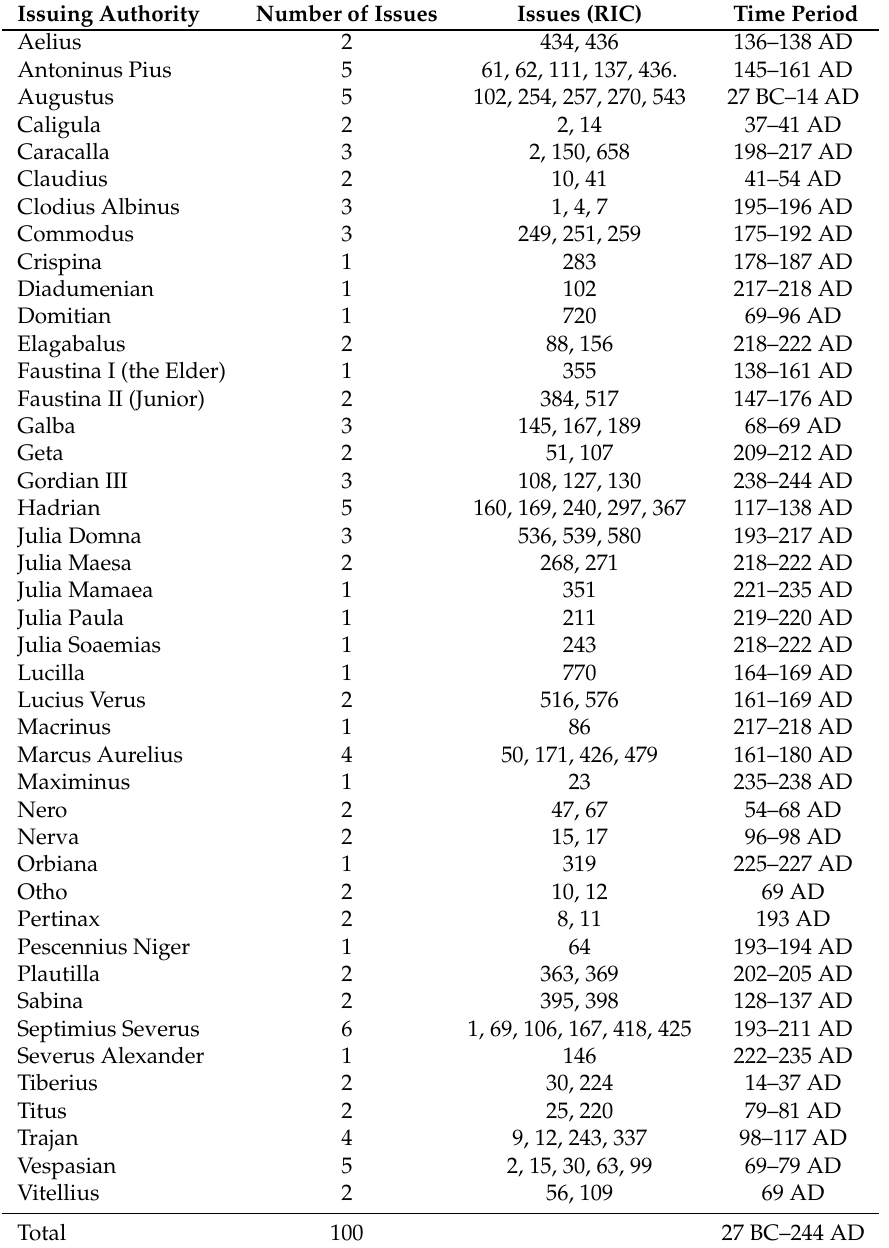
Table 1. Summary of the content of our